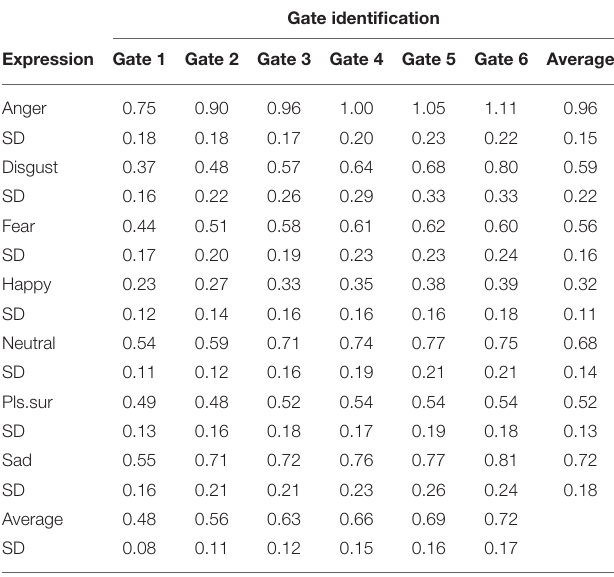
TABLE 4 | Study 2: mean arcsine-transformed H u scores and SD for each emotion at each gate. Gate